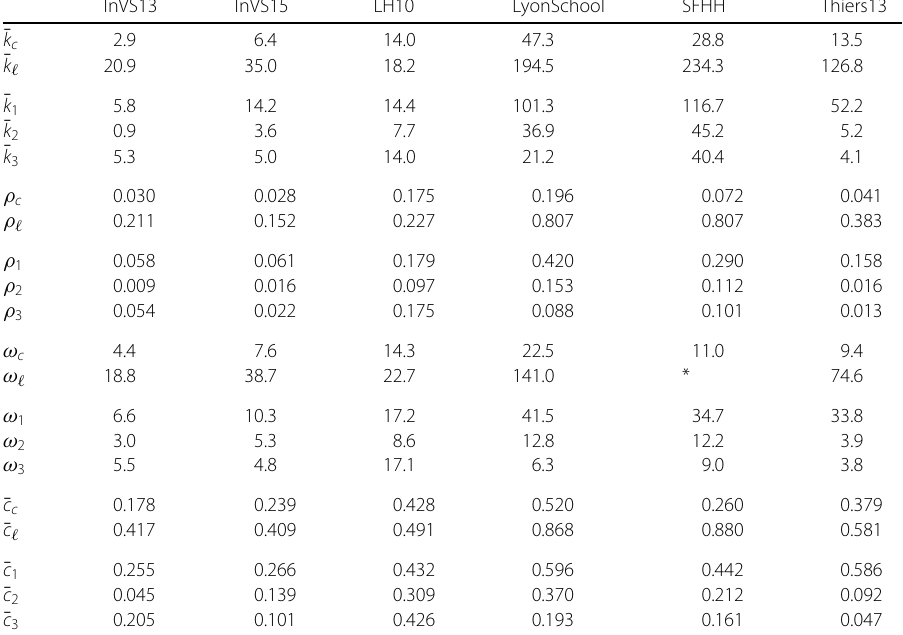
Table 3 Characteristics of the contact, co-presence, and sampled co-presence networks InVS13 InVS15 LH10 LyonSchool